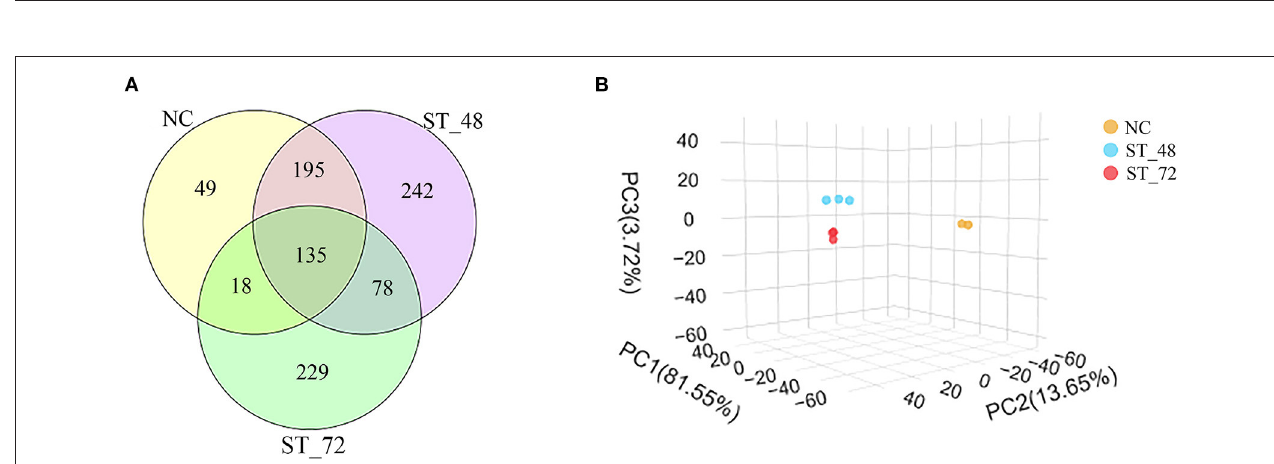
FIGURE 2 | (A) Venn diagram showing the number of intestinal genera in the ileum of the NC, ST_48, and ST_72 groups. (B) Principal coordinate analysis score plots of OTUs among the NC, ST_48, and ST_72 groups.